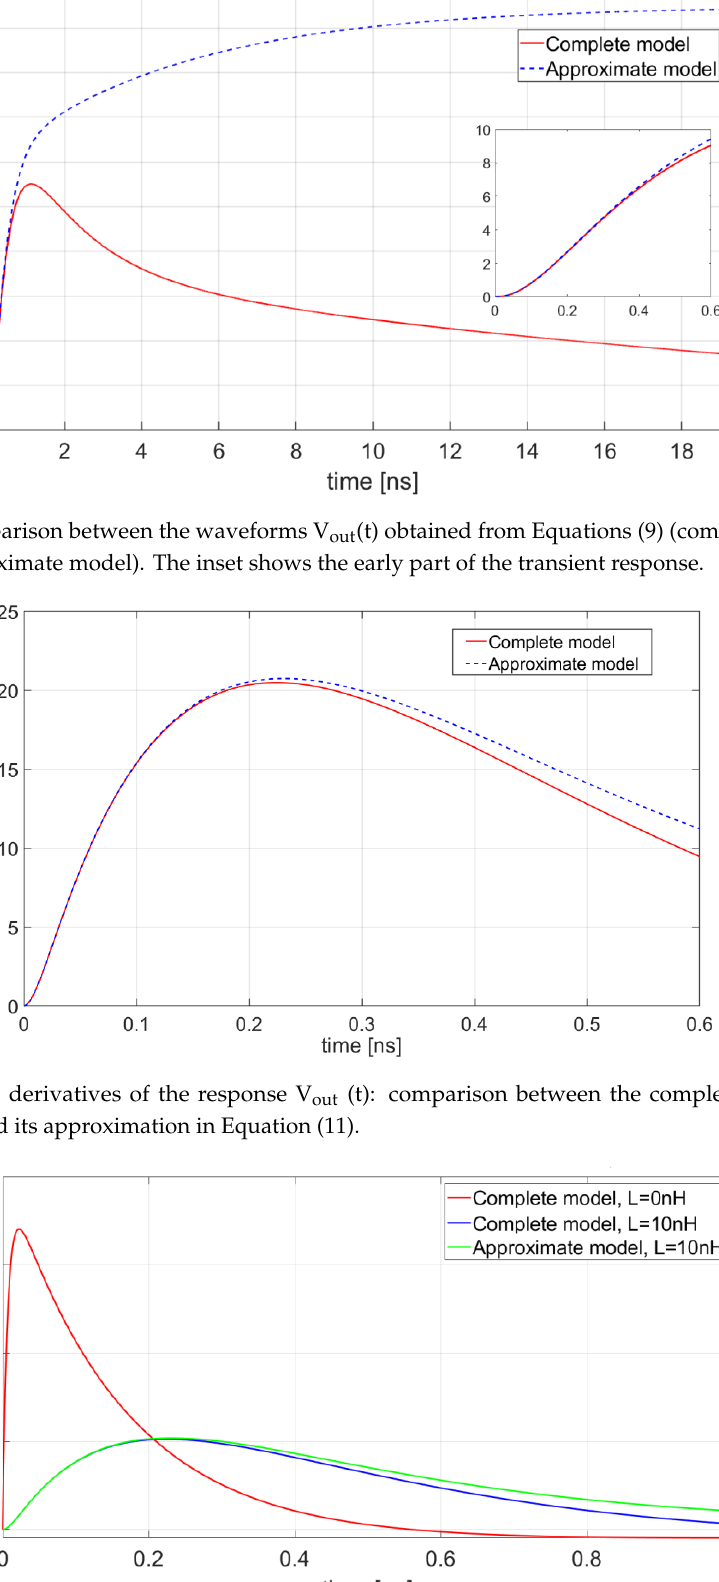
Figure 7. Slope of output pulses obtained with no series inductance and with a 10 nH inductance included in both the complete and approximate models.